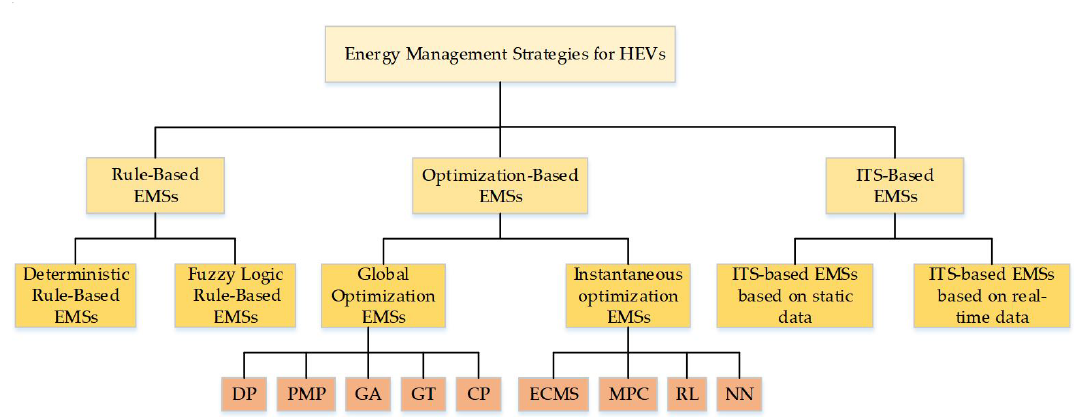
Figure 1. Types of energy management strategies (EMSs) for hybrid electric vehicles (HEVs). Please see Appendix A for a full list of the abbreviations used in the